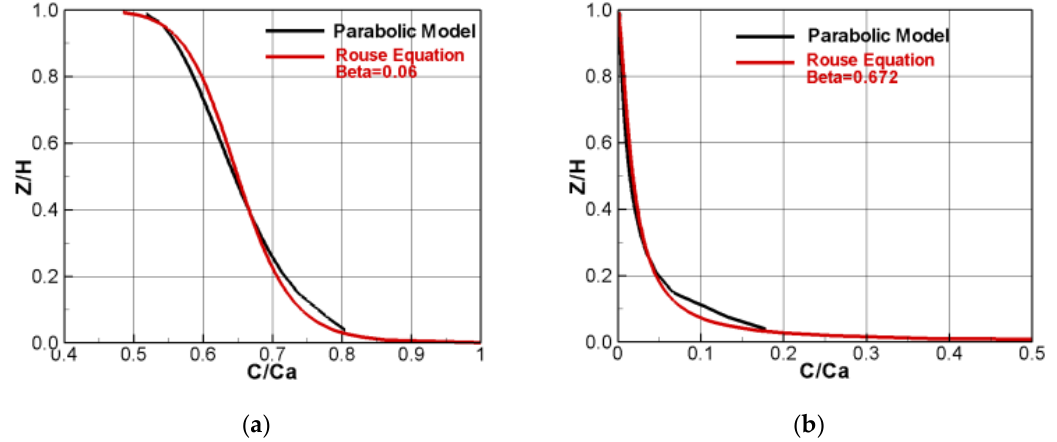
Figure 9. Comparison of suspended sediment concentration vertical distribution for the Fuhrman case (Black line: the model; Red line: Rouse equation). ( a ) Run 1; ( b ) Run 2.